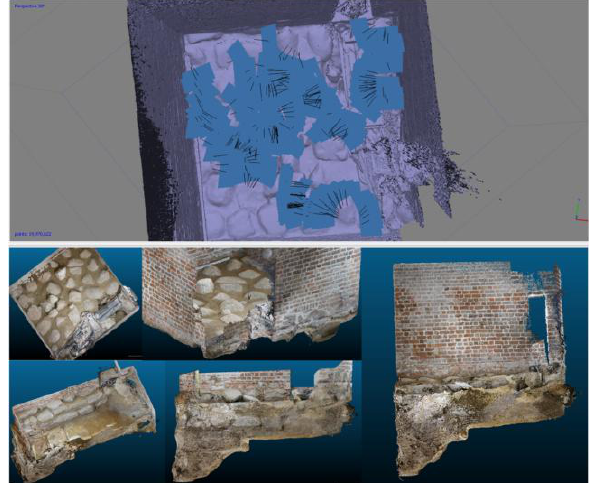
Figure 5. The example of images location and generated point clouds